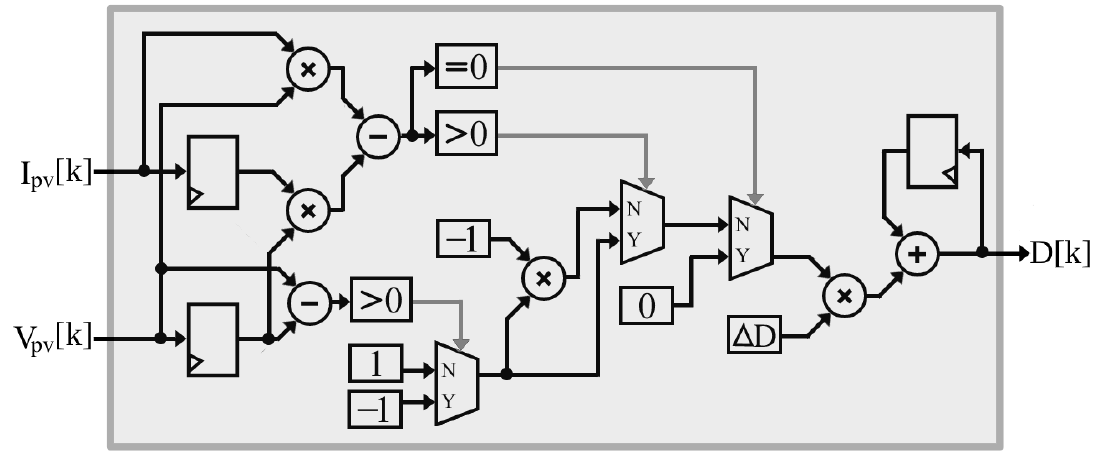
Figure 9. Implementation of P&O algorithm module.